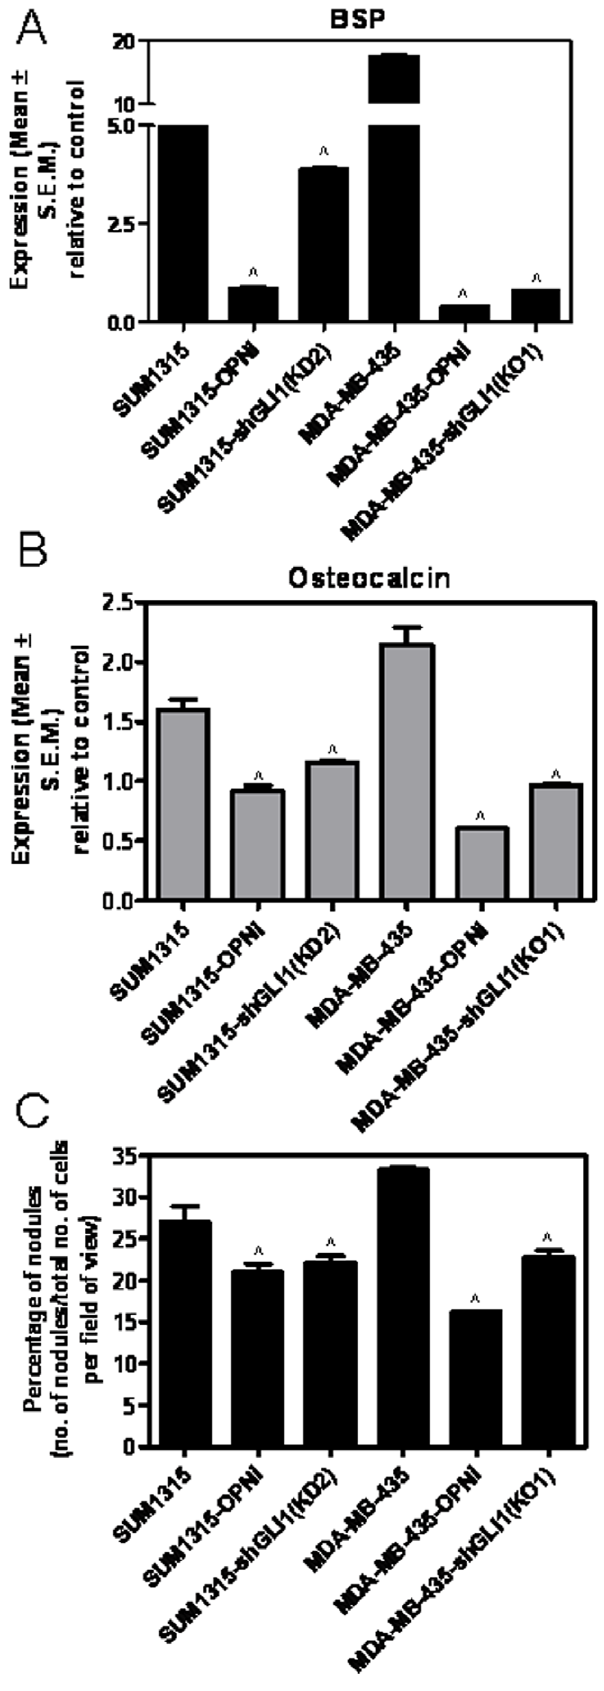
Figure 5. Tumor cells competent for Hh signaling and OPN expression are efficient at inducing osteoblast differentiation. Stable silencing of OPN (OPNi) or GLI1 (KD2 and KO1) from SUM1315 and MDA-MB-435 tumor cells significantly reduces the expression of ( A ) BSP [Relative to SUM1315, SUM1315-OPNi ( ‘ p=0.008) and KD2 ( ‘ p=0.0004) show lower BSP; Relative to MDA-MB-435, 435-OPNi and KO1 have decreased BSP ( ‘ p , 0.0001)], ( B ) osteocalcin [SUM1315-OPNi ( ‘ p=0.0013) and KD2 ( ‘ p=0.0004); 435-OPNi and KO1 ( ‘ p , 0.0001)], and ( C ) the mineralization capacity of the osteoblasts [SUM1315-OPNi ( ‘ p =0.04) and KD2 ( ‘ p=0.04); 435-OPNi ( ‘ p , 0.0001) and KO1 ( ‘ p=0.0003)]. The expression of BSP and osteocalcin were assessed by real time qRT-PCR and the nodules were quantified (in 12 independent fields in triplicate) after Alizarin Red S staining after 14 days of